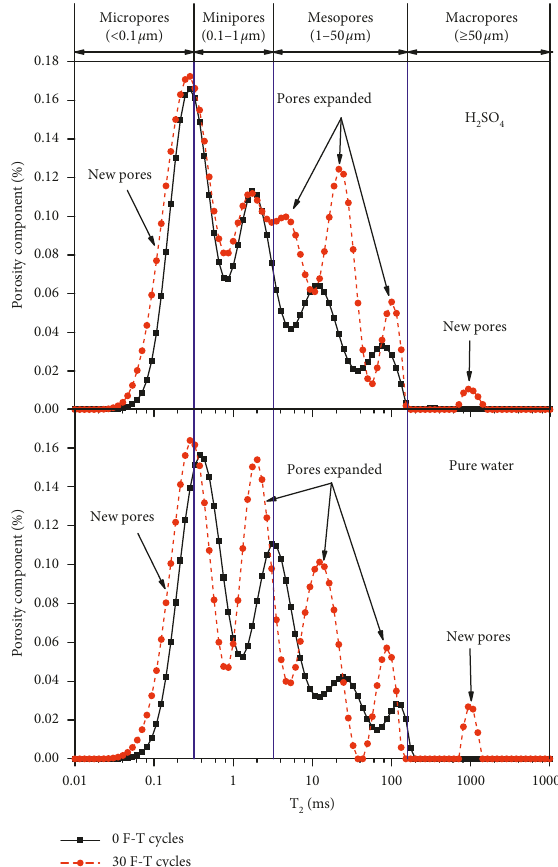
Figure 9: Division of T 2 spectra of sandstone specimens according to pore size in different